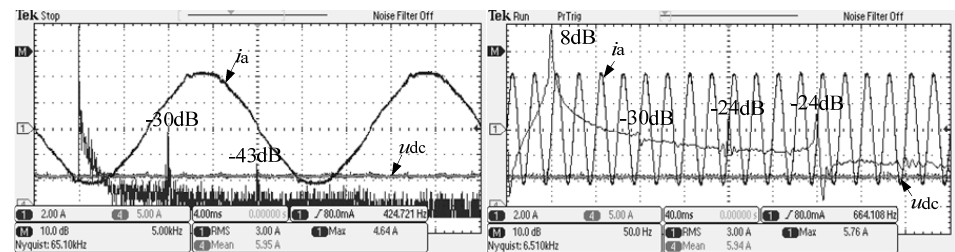
Figure 13. System AC current FFT analysis of traditional passive damping scheme.